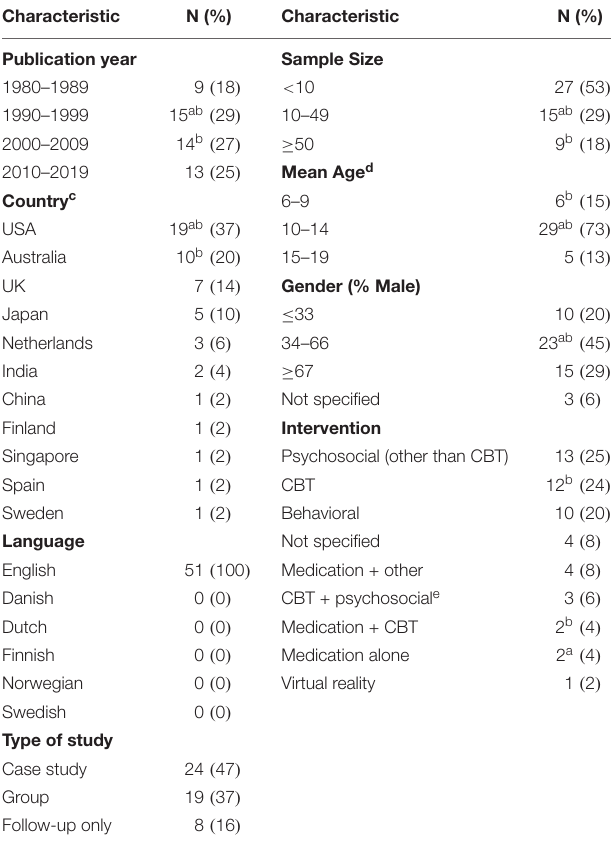
TABLE 1 | Characteristics of studies evaluating intervention for school